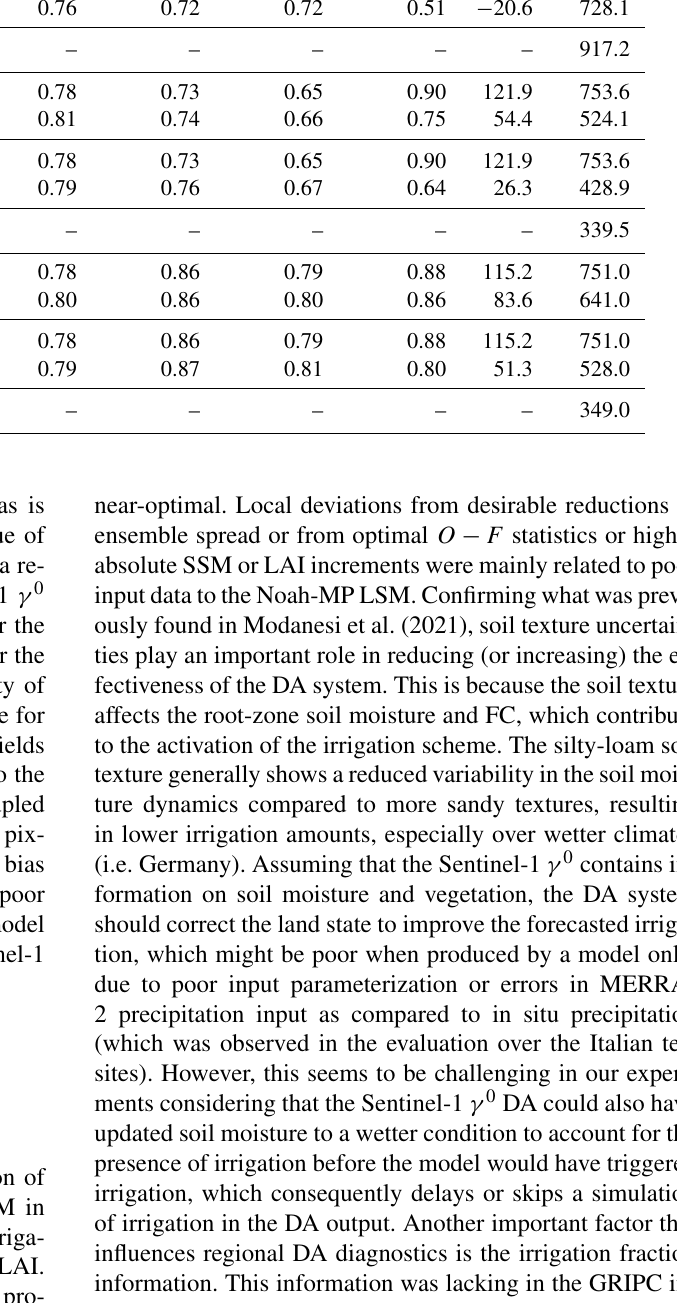
Table 3. Evaluation results at all the Italian test sites and for both the DA experiments. Italy test